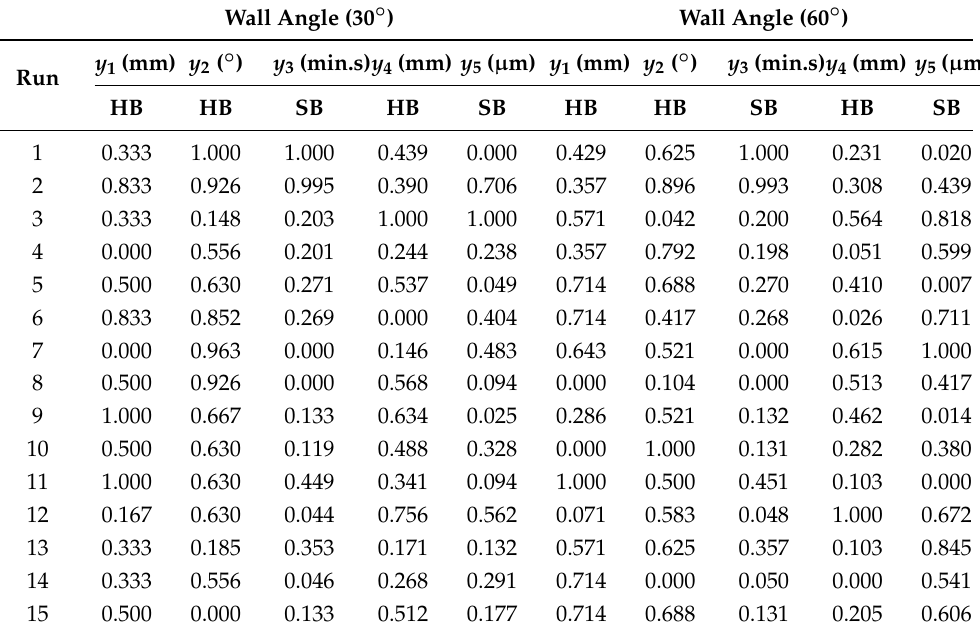
Table 6. Evaluation of deviation